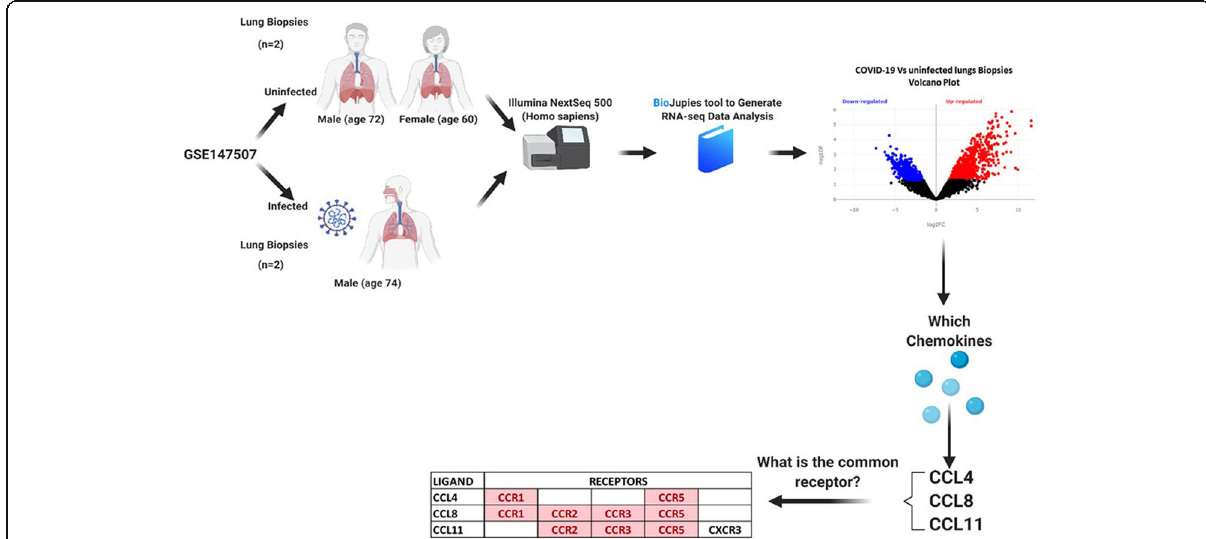
Fig. 3 Flowchart for identification of DEGs between SARS-CoV-2 infected and uninfected lung samples using RNAseq dataset (GSE147507) retrieved from GEO using BioJupies tools. The flow of transcriptomics reanalysis, identification of chemokines, their common receptors, and immune cells with high receptor are